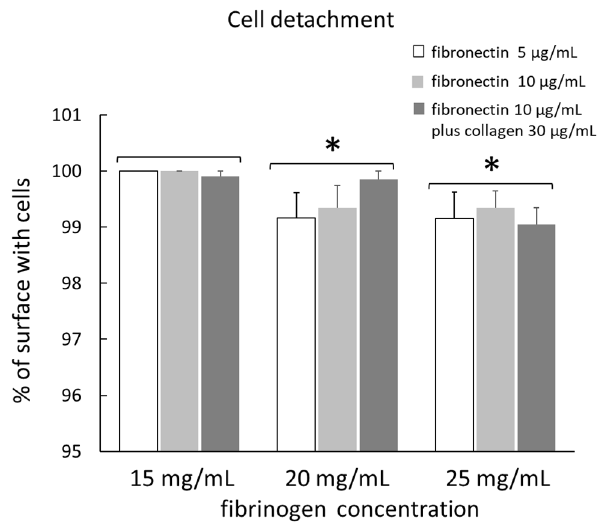
Figure 3. Percentage of gel surface with cells, relative to the total surface, in different gels with different coatings, after the measurement of µ . Data are means of 4 measurements for each type of substrate. *: significantly lower (p < 0.01) than in gel with fibrinogen concentration of 15 mg/mL.